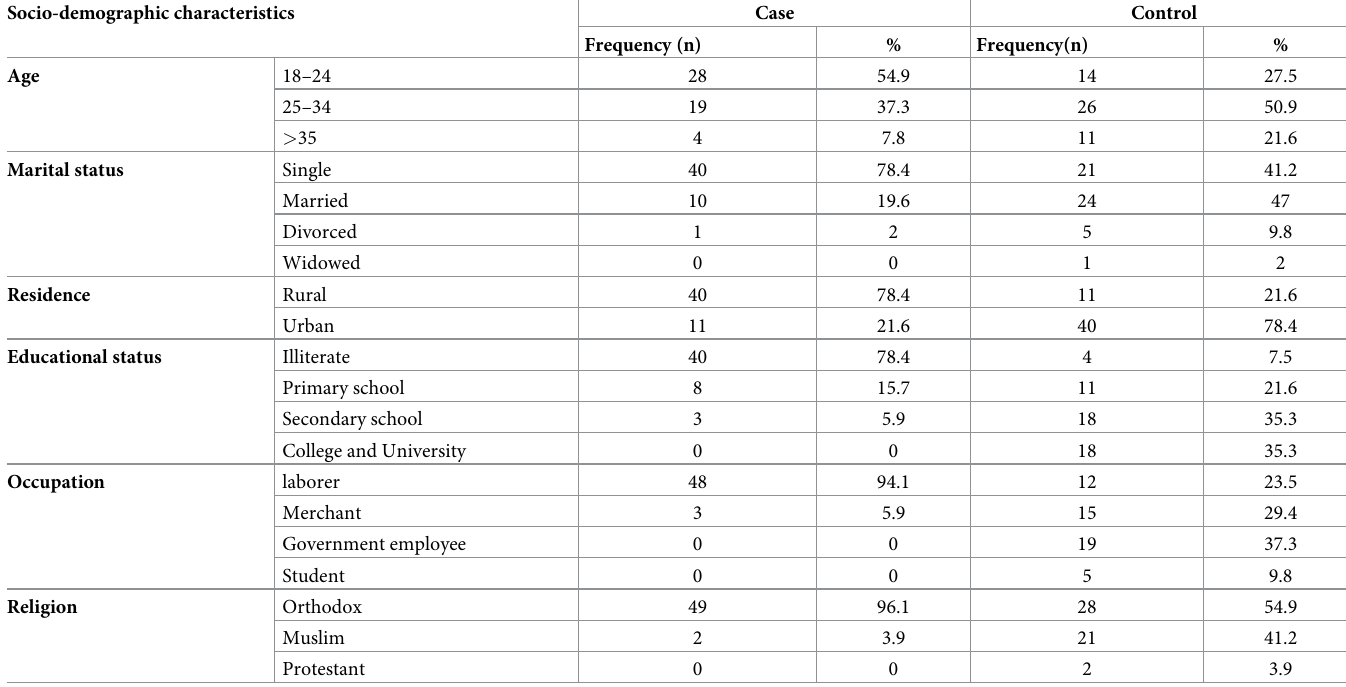
Table 1. Socio-demographic characteristics of the study participants at University of Gondar Comprehensive Specialized Hospital from April to September 2020 (n = 102). Socio-demographic characteristics Case